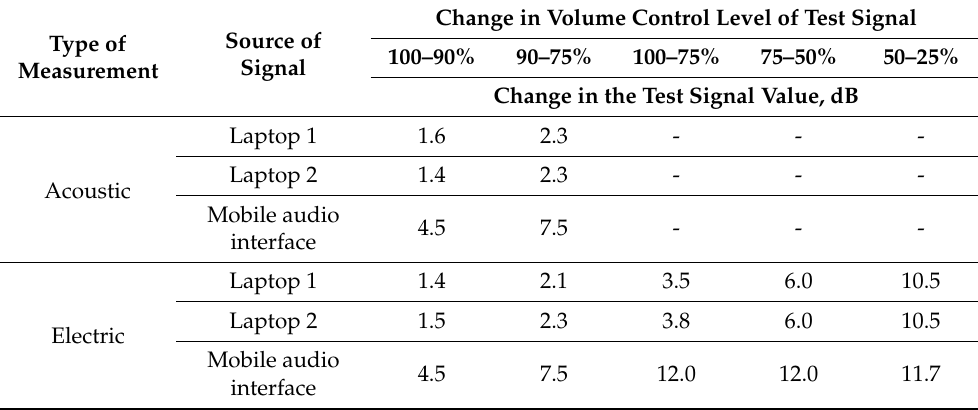
Table 4. Changes in the test signal value due to changes in volume control